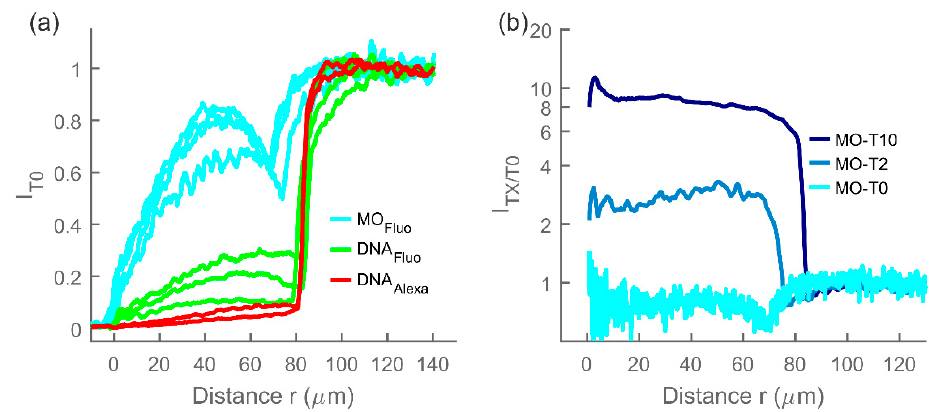
Figure 6. ( a ) normalized fluorescence intensity profiles I T0 of non-binding target T0 (either MO- T0 or DNA- T0 ) in MO hydrogels and DNA hydrogels respectively. MOs were functionalized with carboxyfluorescein dye and DNA oligonucleotides were functionalized either with fluorescein or Alexa 647. ( b ) relative concentration profile I T0 / T0 of non-binding target T0 , compared to equilibrium (or near-equilibrium) relative concentration profiles of binding targets T2 and T10 ( I T2 / T0 and I T10 / T0 ). The individually prepared hydrogels for these data extend up to r = 66 µ m, 72 µ m, and 82 µ m for the nonbinding T0 and T2 and T10 binding targets, respectively.